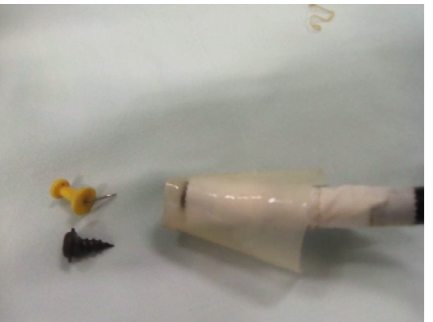
Figure 5: Elongated pin and thick screw safely extracted. Note the bended tip of the pin which was impacted in the antrum